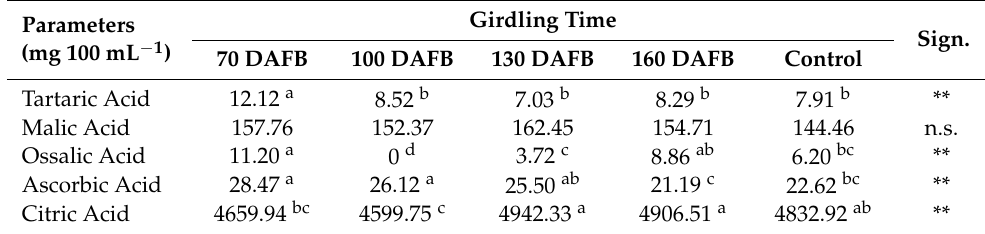
Table 5. Effects of girdling time on the main organic acid composition of juice (HPLC). Parameters